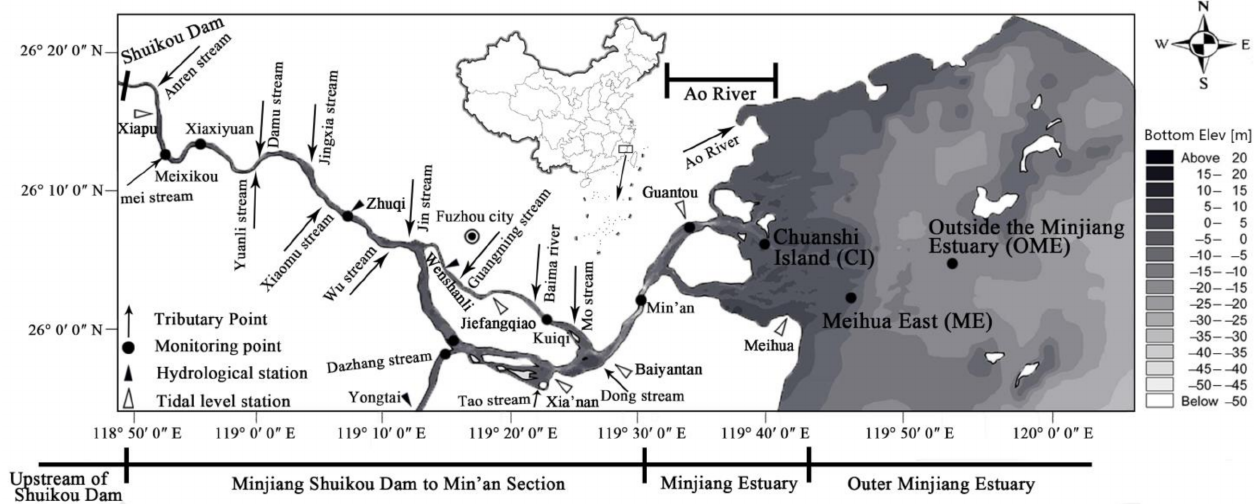
Figure 1. Minjiang River bottom elevation, hydrology, and water quality observation stations along the Minjiang River up to the sea; the regional distribution of DIN and 14 main tributaries are also